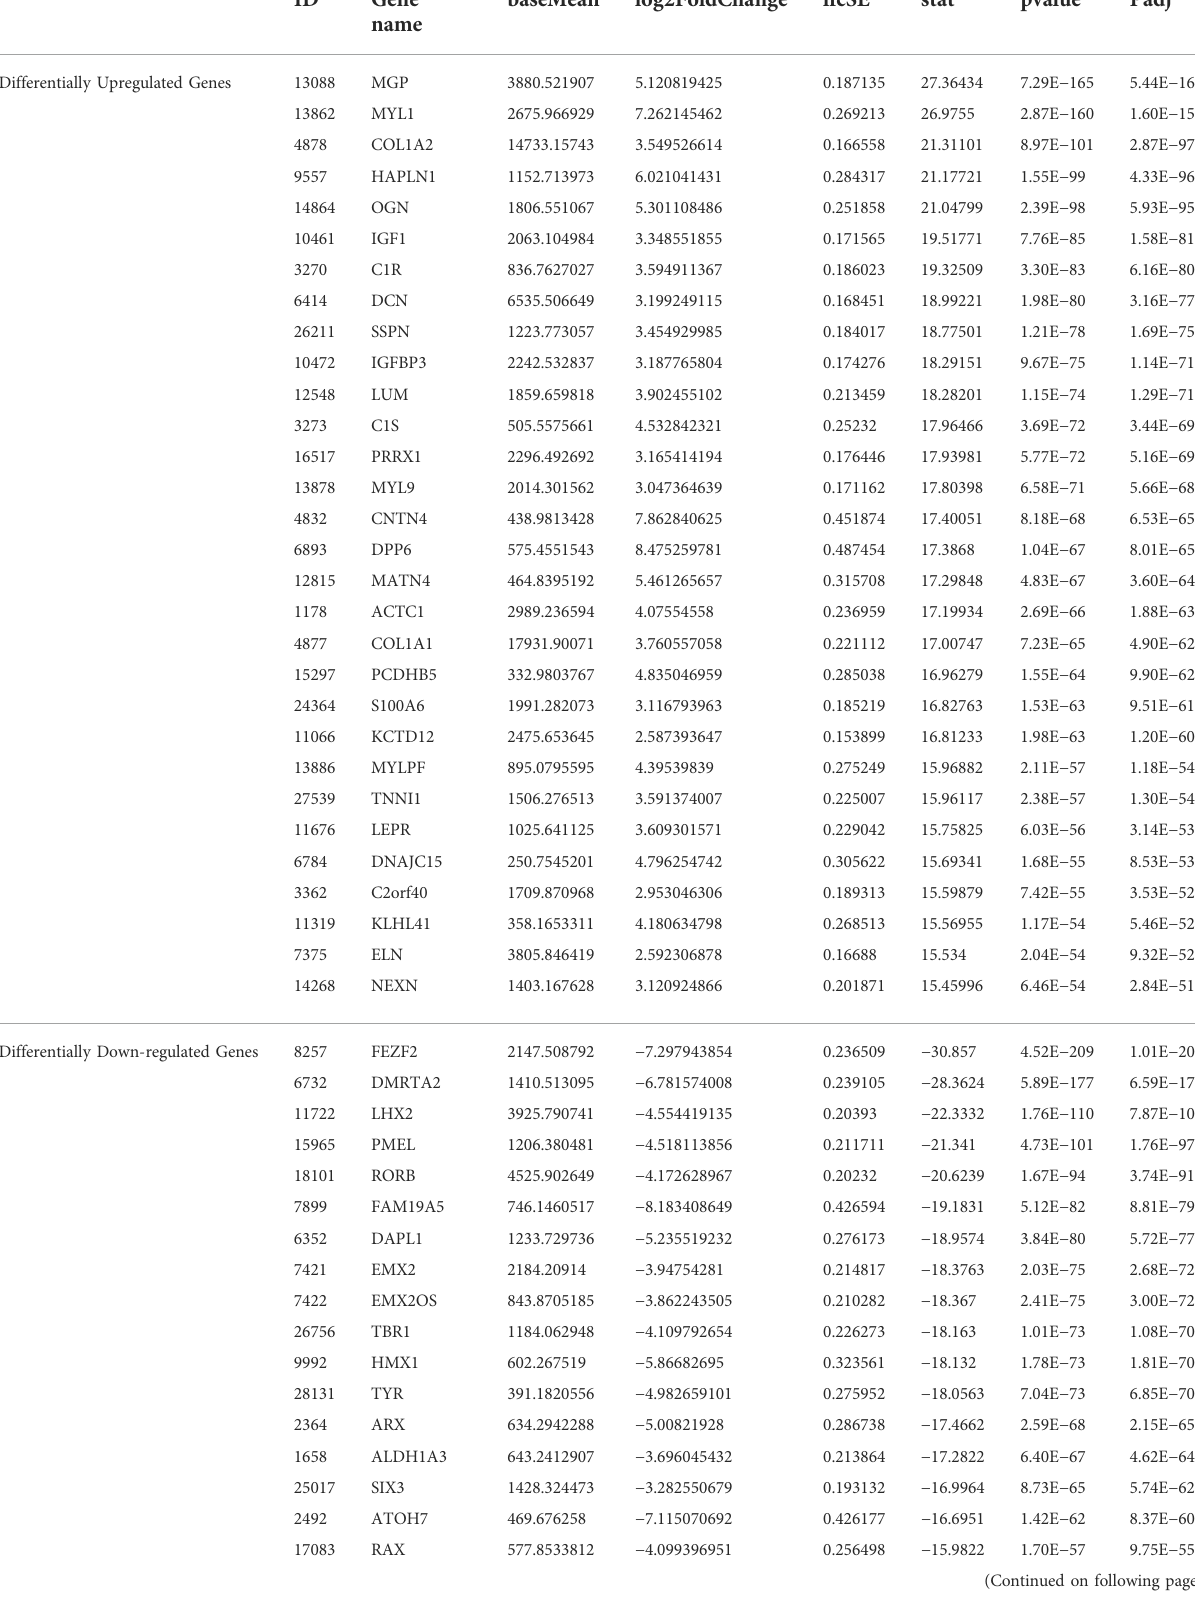
TABLE 3 Top30 differentially upregulated and down-regulated genes in DMD-COs versus